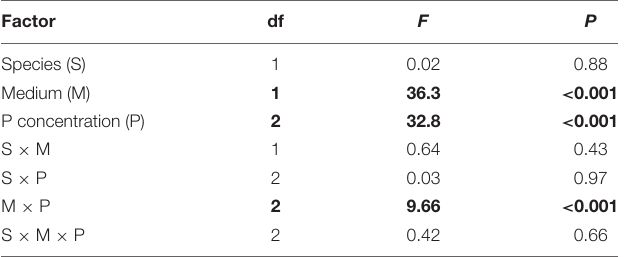
TABLE 3 | Results of three-way ANOVA testing the effects of species ( C. elongata vs. C. silvae-gabretae ), media (inorganic vs. organic), and three P concentrations on cell-specific phosphatase activity.